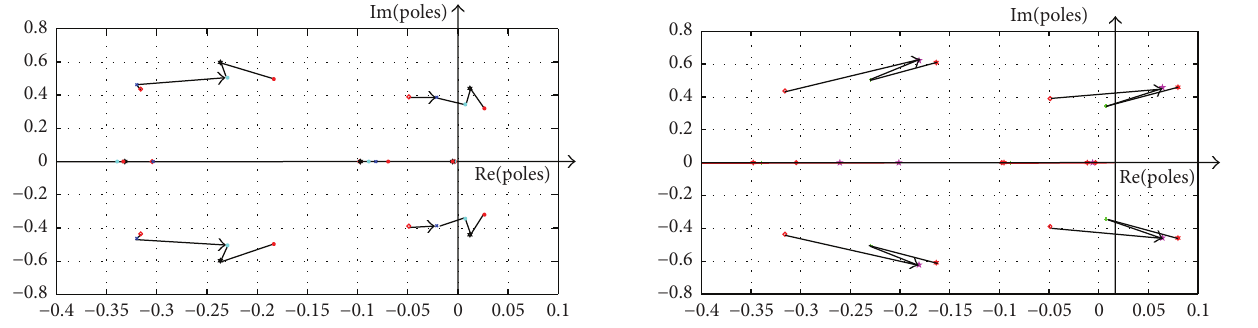
Figure 6: Enlarged view of Figure 5 showing poles locus near to Re(poles) = 0